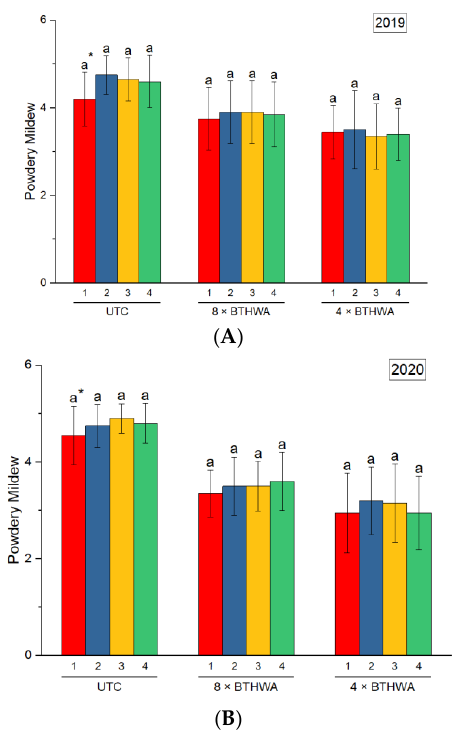
Figure 3. The powdery mildew disease incidence in zucchini ( Cucurbita pepo convar. giromontiina ) for four experimental blocks in response to different variants of treatment with BTHWA in 2019 ( A )